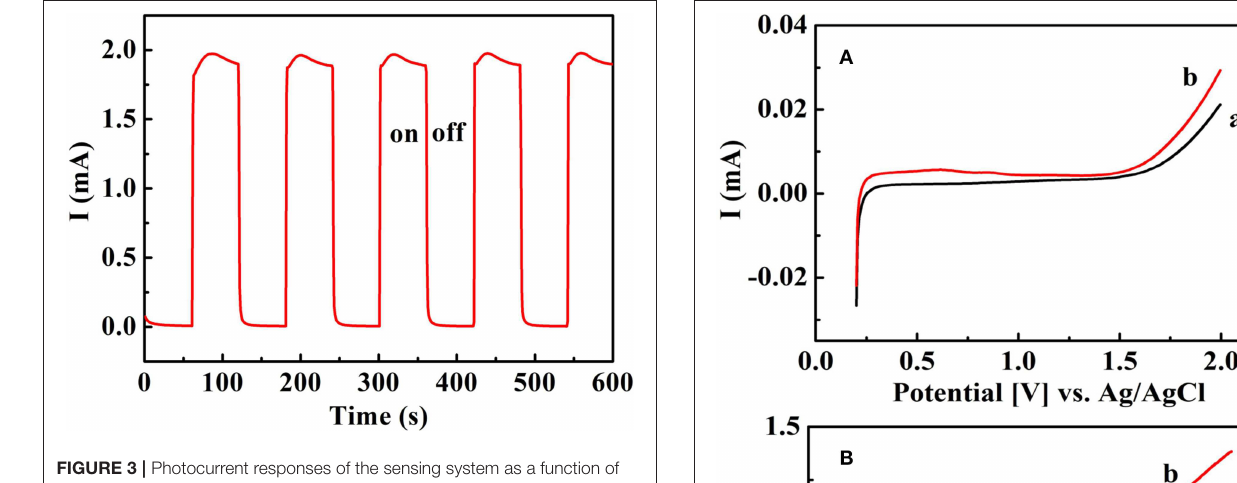
FIGURE 3 | Photocurrent responses of the sensing system as a function of time at the repeated on/off cycles with an applied potential 1.5V under UV illumination. 0.2mM Na 2 SO 4 solution as the supporting electrolyte.